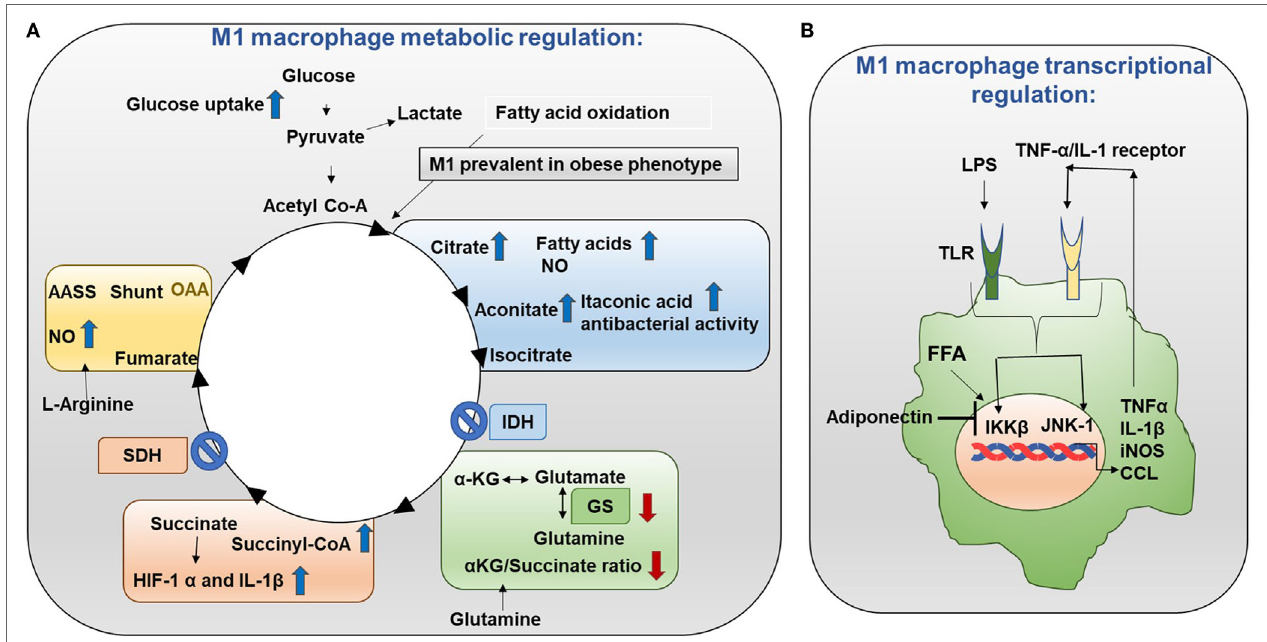
FiguRe 3 | Metabolism in M1 macrophages. (A) M1 macrophage metabolic regulation: M1 macrophages are prevalent in obese adipose tissue. Glucose uptake is increased in M1 macrophages. Importantly, the TCA cycle exhibits two breaks. The first break involves the enzyme isocitrate dehydrogenase (IDH) which results in increased levels of citrate and itaconic acid. Citrate feeds fatty acid (FA) synthesis for prostaglandin (PG) and nitric oxide (NO) production while itaconic acid has anti-bacterial properties. The second break happens with the enzyme succinate dehydrogenase (SDH) which causes increased succinate levels. Succinate stabilizes HIF-1 α which binds to the interleukin (IL)-1 β promoter boosting IL-1 β production and inflammation. Increased flow through the aspartate arginosuccinate shunt (AASS) replenishes the TCA cycle which further increases citrate levels and feeds the urea cycle which contributes to NO production. Glutamine is converted into glutamate by glutamate synthase (GS). Glutamate can further be converted into α -ketoglutarate ( α KG). Low α KG/succinate ratio strengthens M1 macrophage activation. Glutamine-synthetase inhibition skews M2-polarized macrophages toward the M1-like phenotype characterized by reduced intracellular glutamine and increased succinate with enhanced glucose flux through glycolysis which is partly related to HIF-1 α activation. (B) M1 macrophage transcriptional regulation: in M1 macrophages, the TCA cycle is broken. As a result, citrate is converted to free fatty acids (FFAs). FFAs activate macrophage IKK and JNK1 signaling molecules to induce M1 polarization. Activation of IKK and JNK1 in macrophages produces IL-1 β and TNF α which can initiate inflammatory response. Adiponectin is released from adipose tissue and is involved in the breakdown of fatty acids. Adiponectin signaling inhibits M1